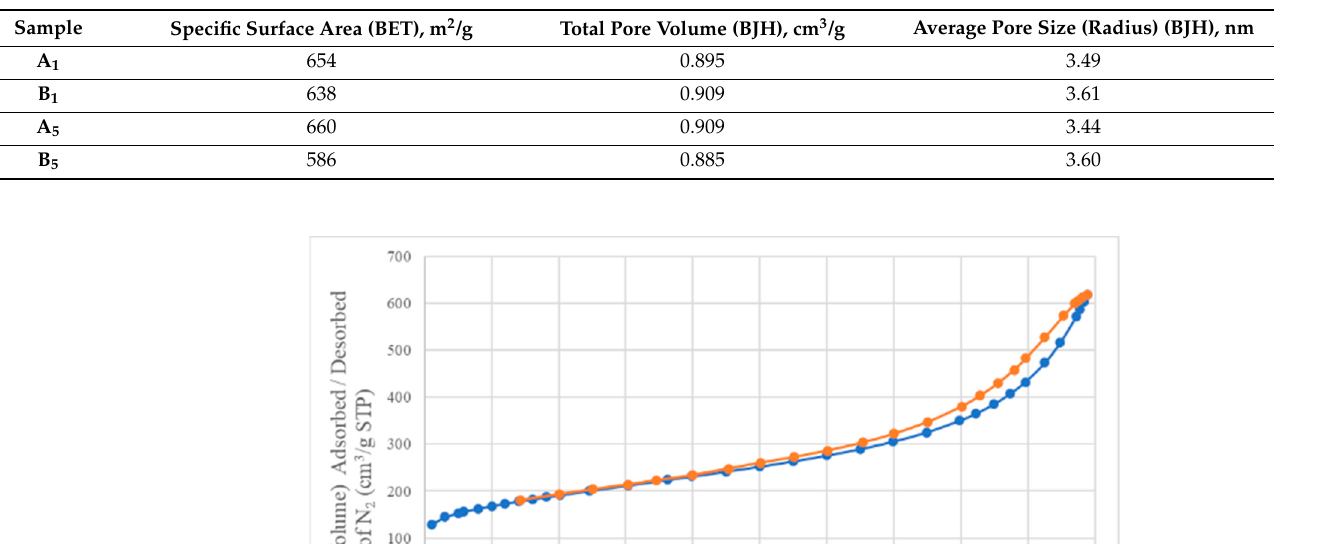
Table 6. Textural properties of the samples.